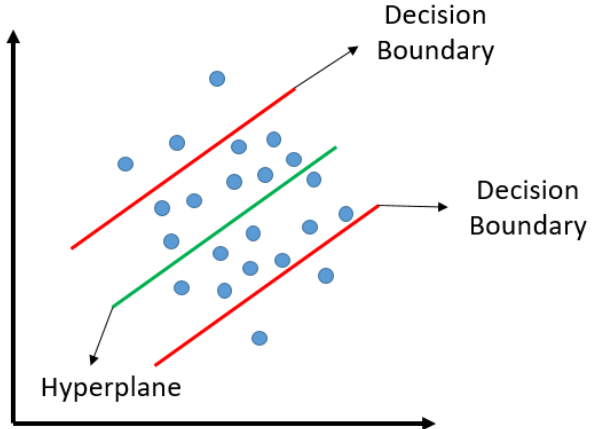
Figure 4. Support Vector Machine Representation.